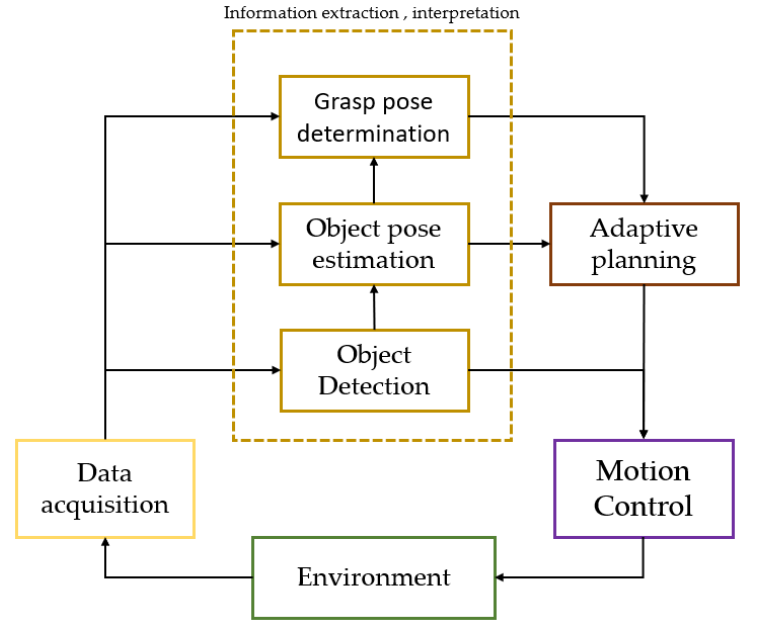
Figure 2. Typical pipelines of computer-vision based industrial robot